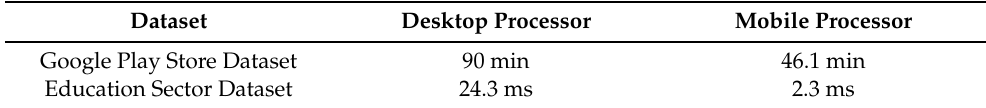
Table 3. Clustering